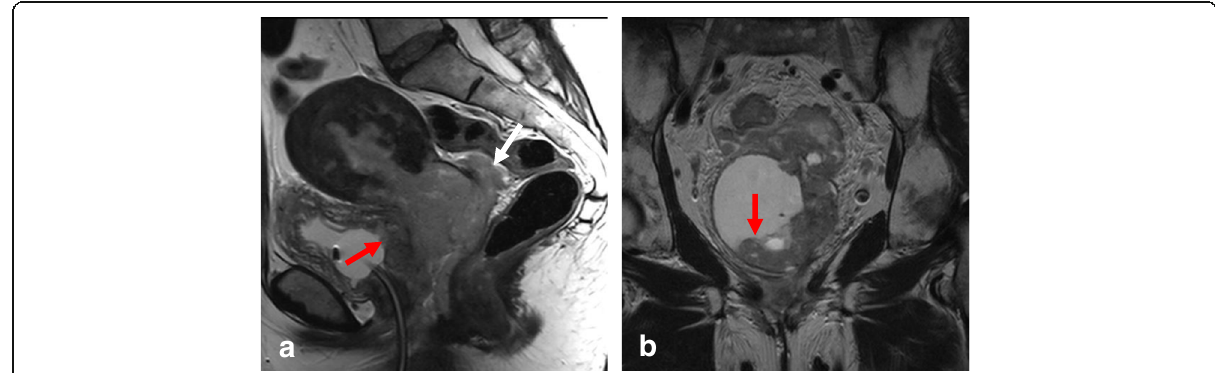
Fig. 17 FIGO Stage IVA cervical cancer with bladder invasion. Visualization by sagittal T2WI ( a ) and coronal T2WI ( b ) reveals cervical cancer invading the bladder mucosa (red arrow) and rectouterine space (white arrow)